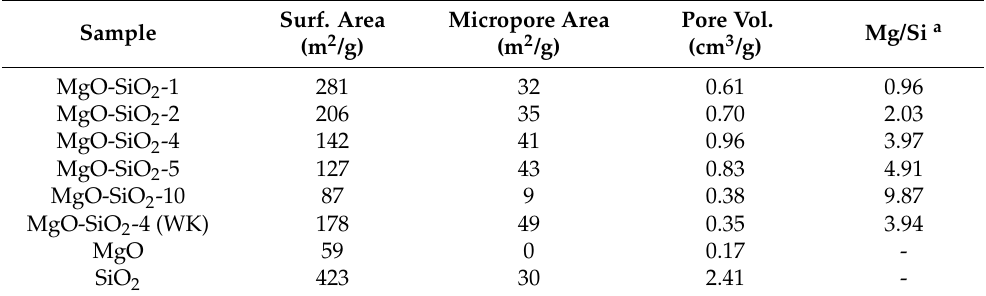
Table 1. Physicochemical properties of MgO-SiO 2 catalysts prepared by ammonia evaporation and wet-kneading (WK). Surf. Sample